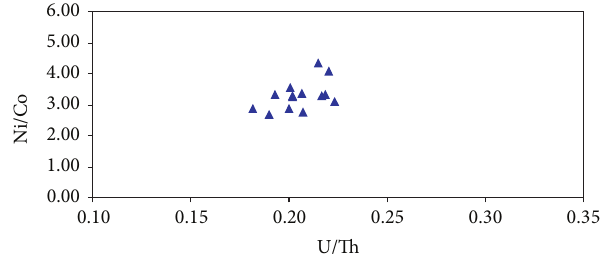
Figure 8: The cross plot showing the relationship between U/Th ratios and Ni/Co ratios of Miocene source rocks of well BD20-1-1 in the Qiongdongnan Basin. Note: the samples in the chart are from the neritic